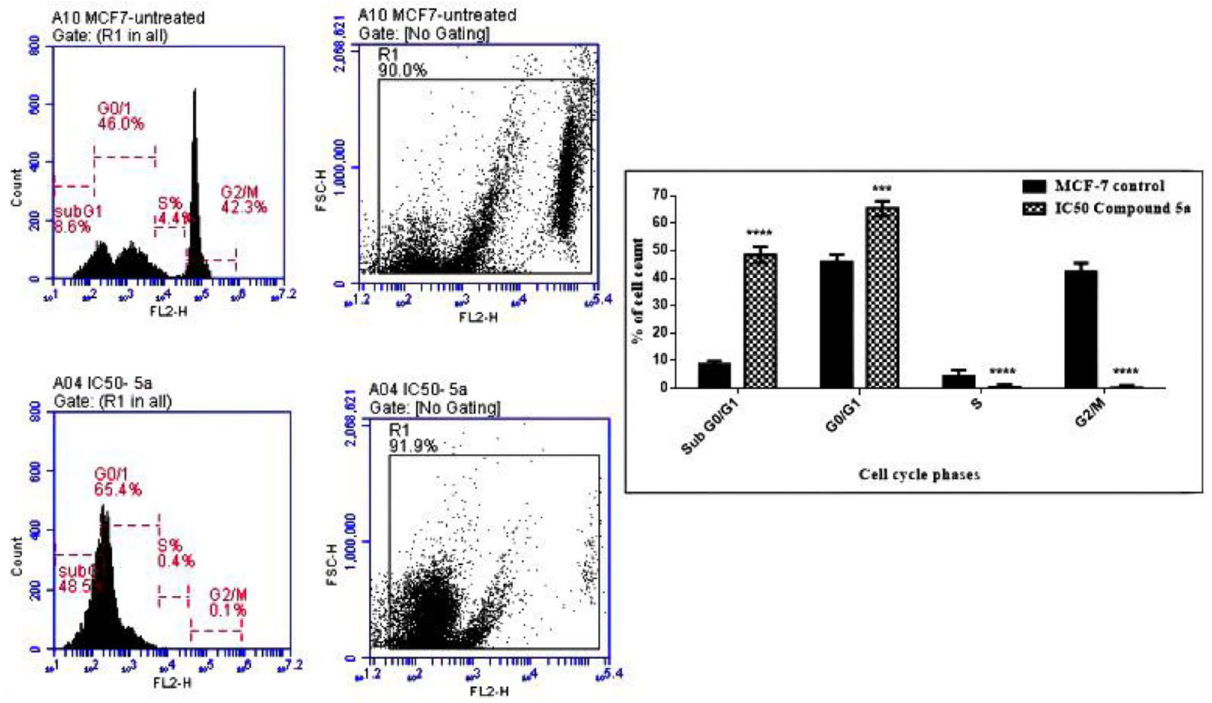
Figure 7. Cell cycle phases in MCF-7 cells treated with IC 50 of compound 5a after 48 h treatment.